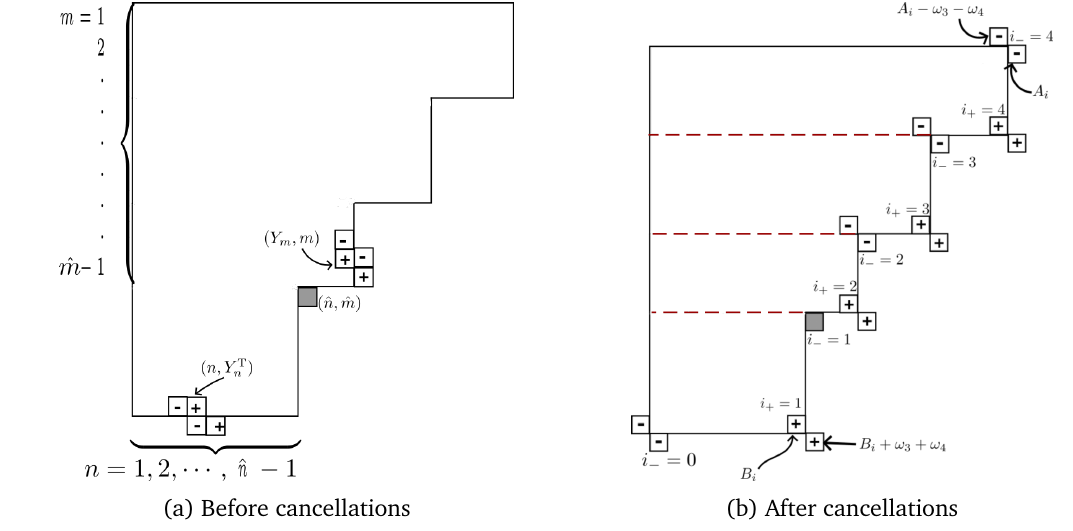
Figure 2: The left figure is a diagrammatic representation of eq. (B.20). Each term in the products in (B.20) are represented by four boxes along the edge of Y , with a ‘ + ’ box representing an S in the numerator and a ‘ − ’ box representing an S in 2 2 the denominator. After various cancellations the leftover factors in eq. (B.21) can be expressed in terms of the distance of the boxes from the extra box as shown in the right figure. The red dashed lines indicate the division into n r